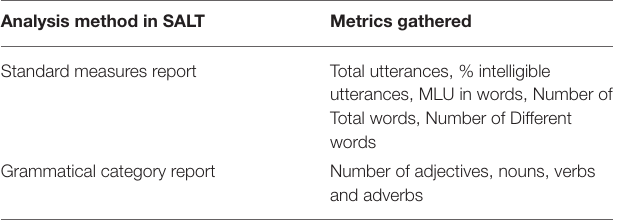
TABLE 1 | Analysis method and metrics gathered via SALT